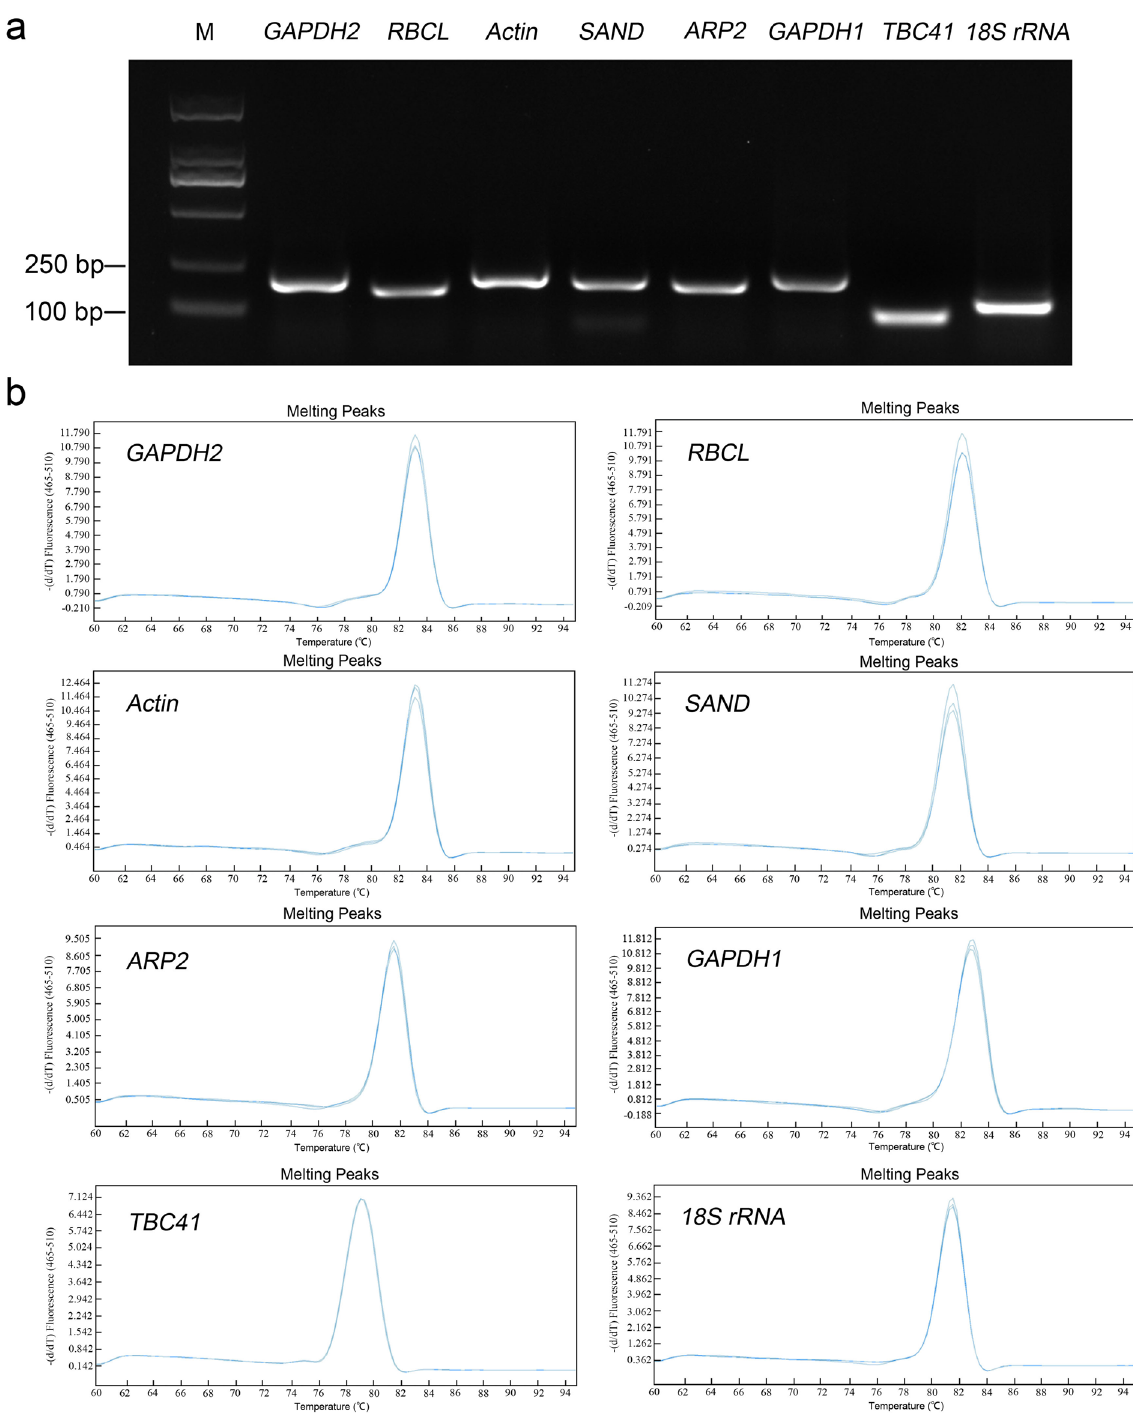
Figure 1. Amplification specificity of primers using qRT-PCR. ( a ) Cropped agarose gel of eight candidate reference genes PCR products, and full-length gel is presented in Supplementary Fig. S1. ( b ) Uniformity of melting curves of amplified product for each candidate reference gene. The ( a ) was generated by ChemiDoc Touch Gel Imaging System (version 1708370; https ://www.bio-rad.com/), the ( b ) was generated by LightCycler480 software (version 1.2.0.169; https ://lifes cienc e.roche